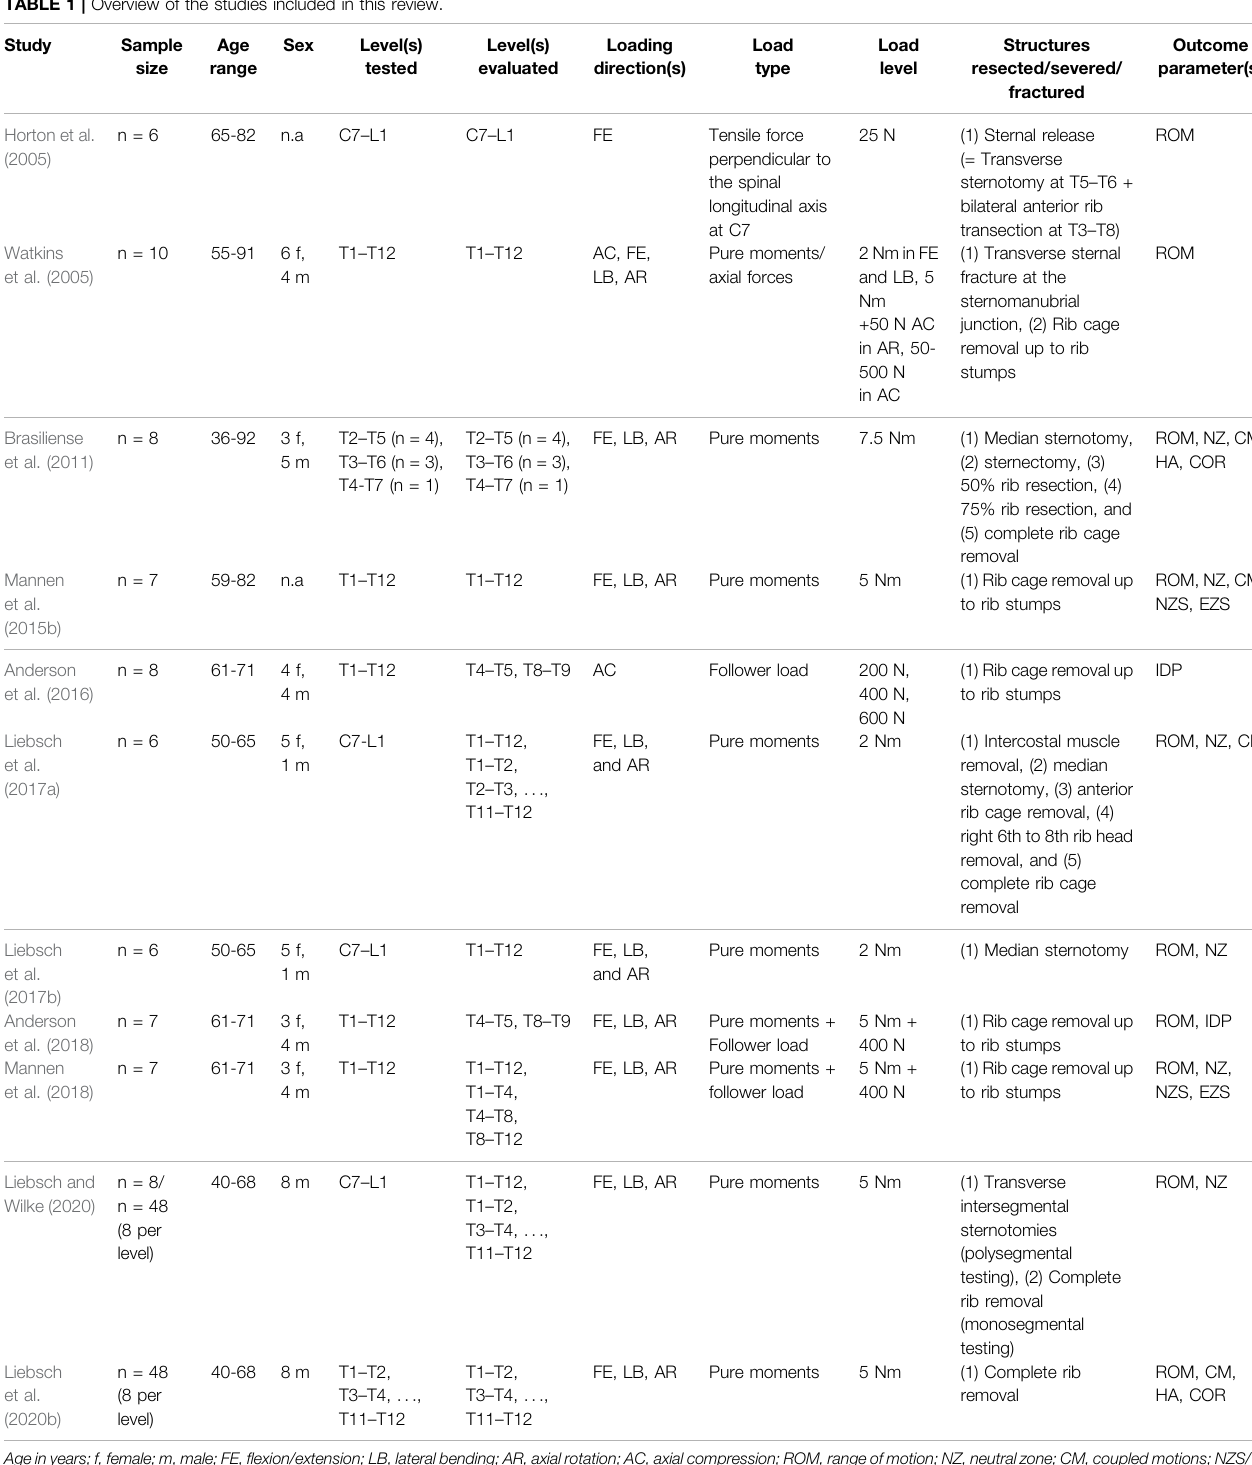
TABLE 1 | Overview of the studies included in this